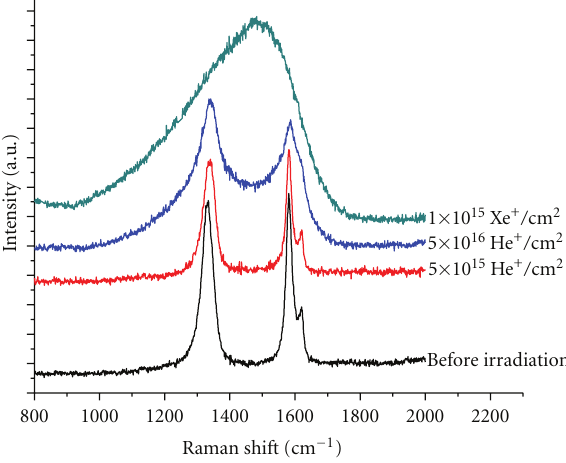
Figure 5: Raman spectra of